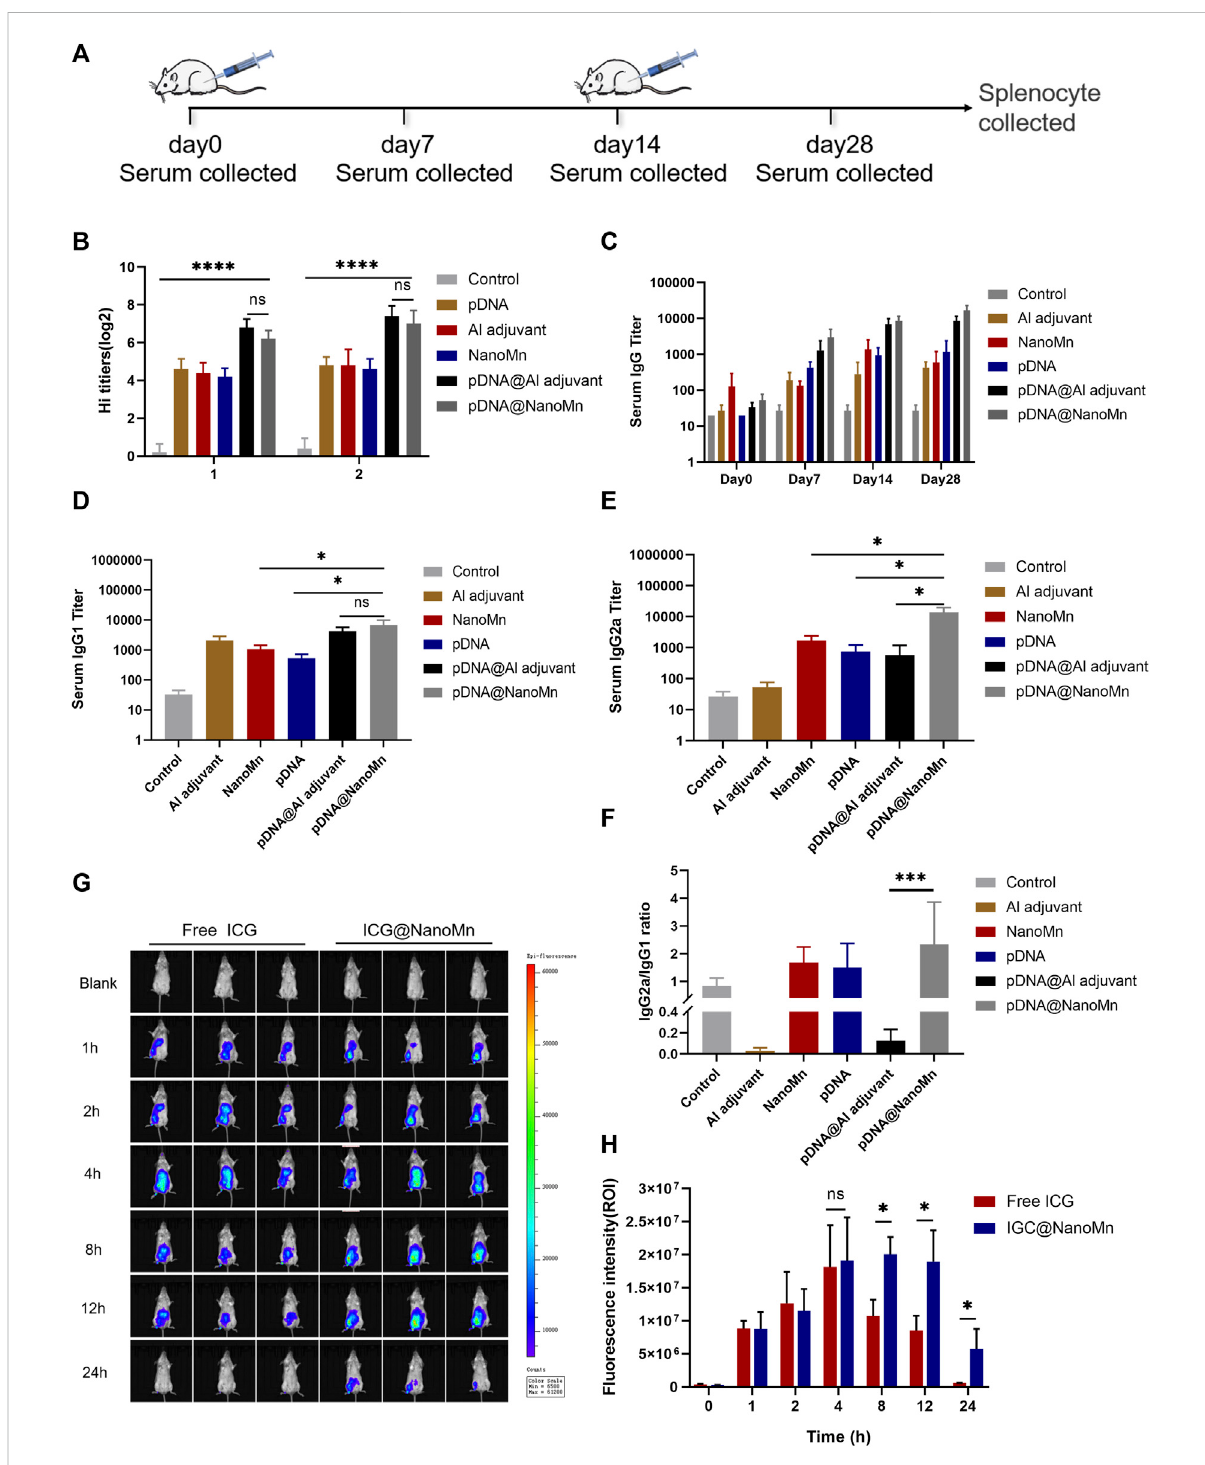
FIGURE 4 (A) Schematic diagram of the mouse immunization protocol. (B) HI antibody titers on the 14th and 28th days after immunization. (C) IgG antibody titers in serum at different time points (D – E) Serum IgG2 and IgG1 titers on day 28 after immunization. (F) Ratio of IgGI to IgG2a. (G) In vivo imaging of small animals at different time points. (H) Quantitative analysis of fl uorescence intensity at injection sites at different time